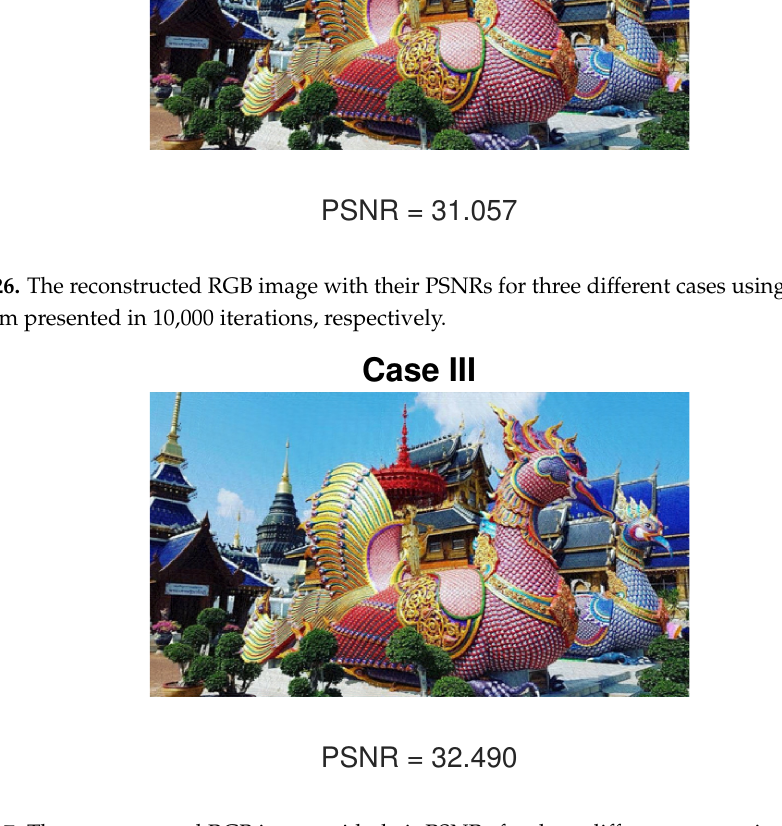
Figure 27. The reconstructed RGB image with their PSNRs for three different cases using the proposed algorithm presented in 10,000 iterations,